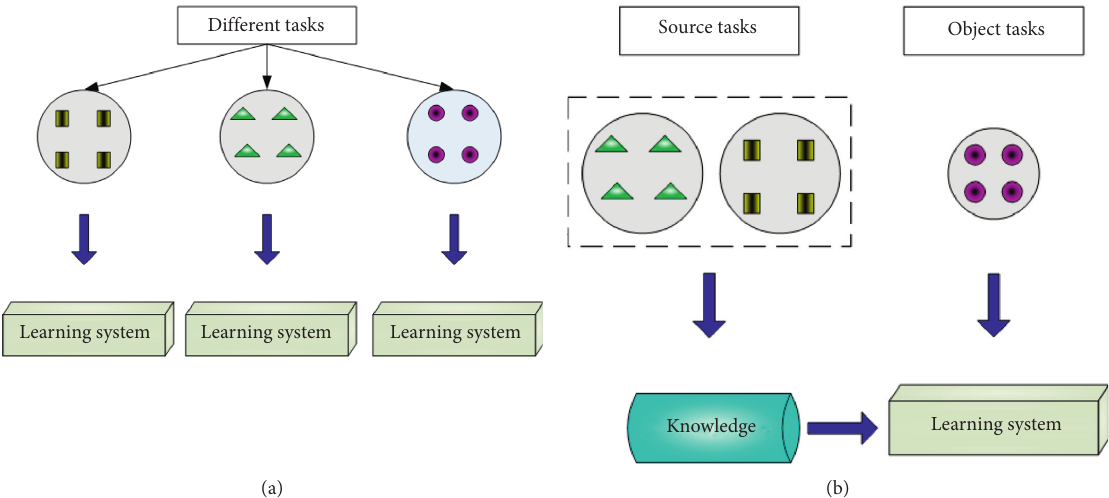
Figure 1: Comparison between traditional machine learning and transfer learning. (a) Learning process of traditional machine learning and (b) learning process of transfer learning.